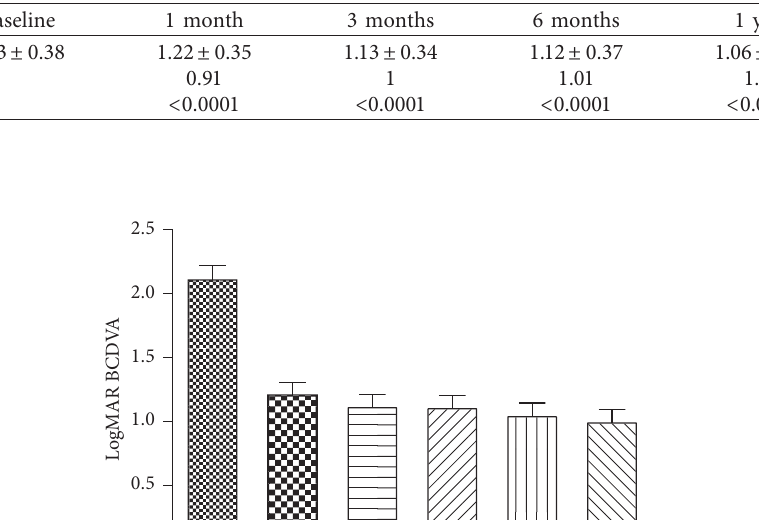
Table 2: The mean BCDVA changes in LogMAR.